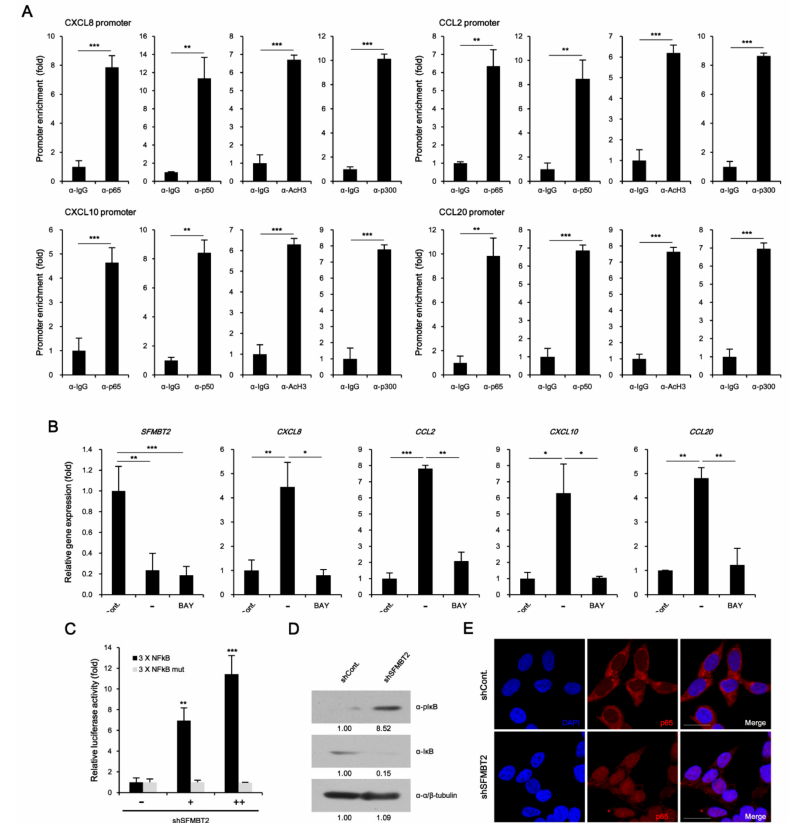
Figure 5. Activation of NF- κ B results in the up-regulation of chemokine gene expression in